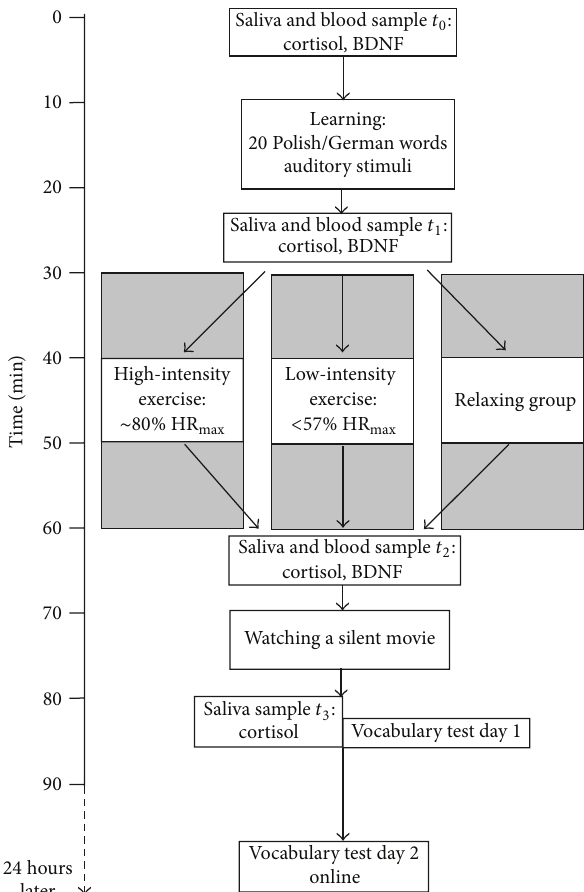
Figure 1: Overview of the experimental learning session with the timing of blood and saliva collection, learning, exercise interven- tion, and vocabulary